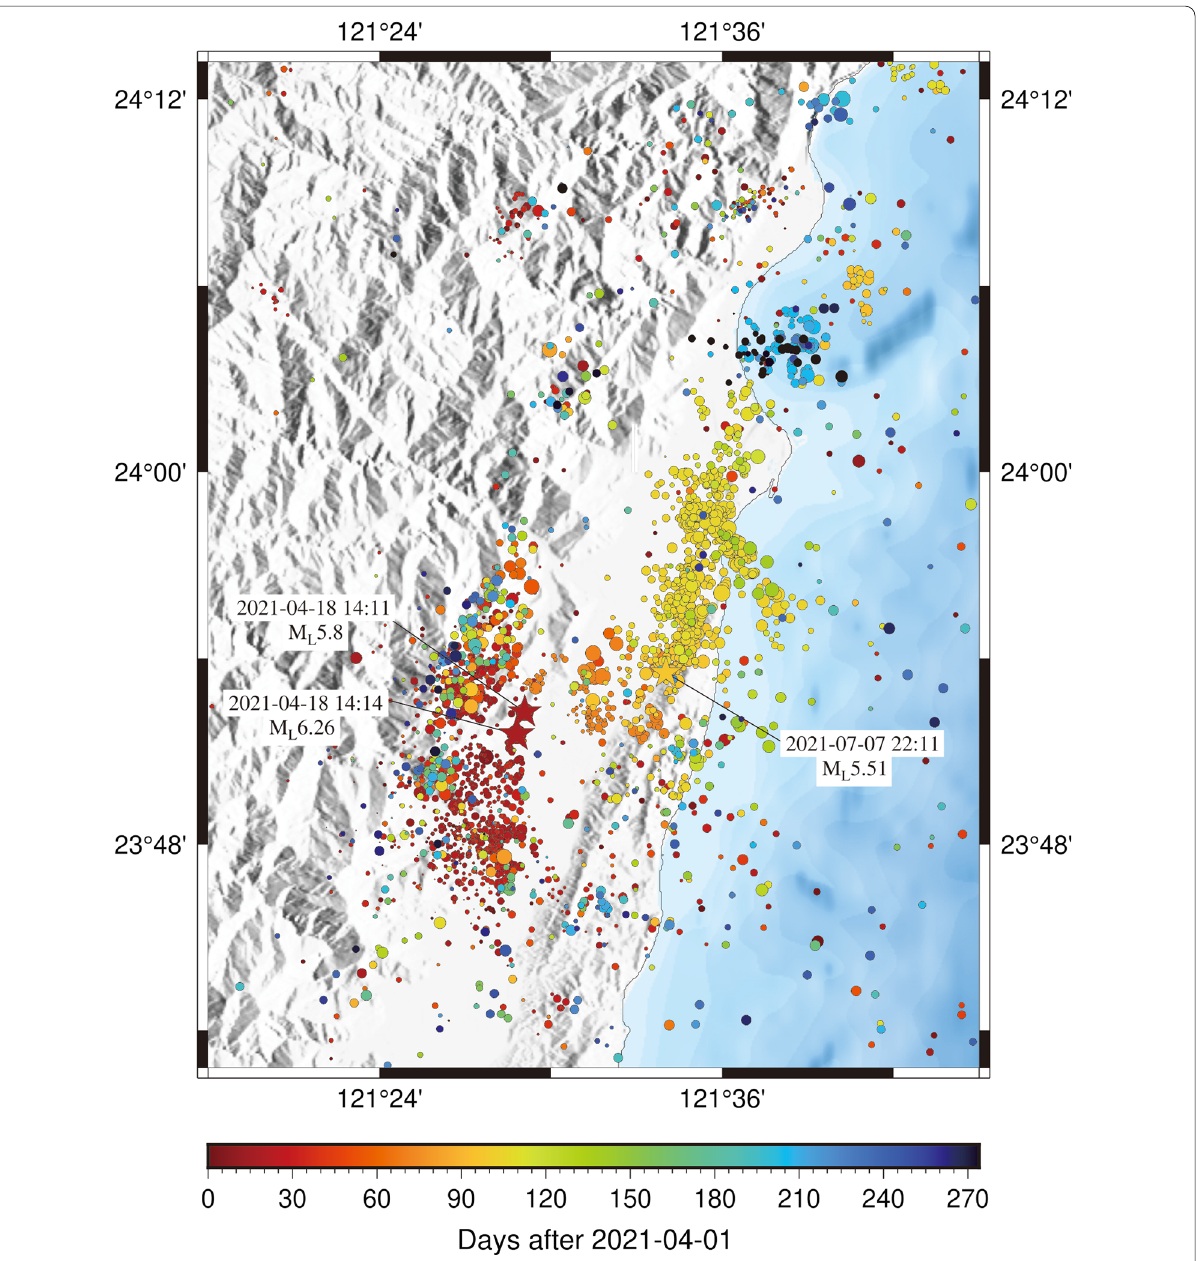
Fig. 3 The spatiotemporal distribution of the Hualien earthquake swarm activities from April to December of 2021. The symbol color represents the time in days after April 1st,